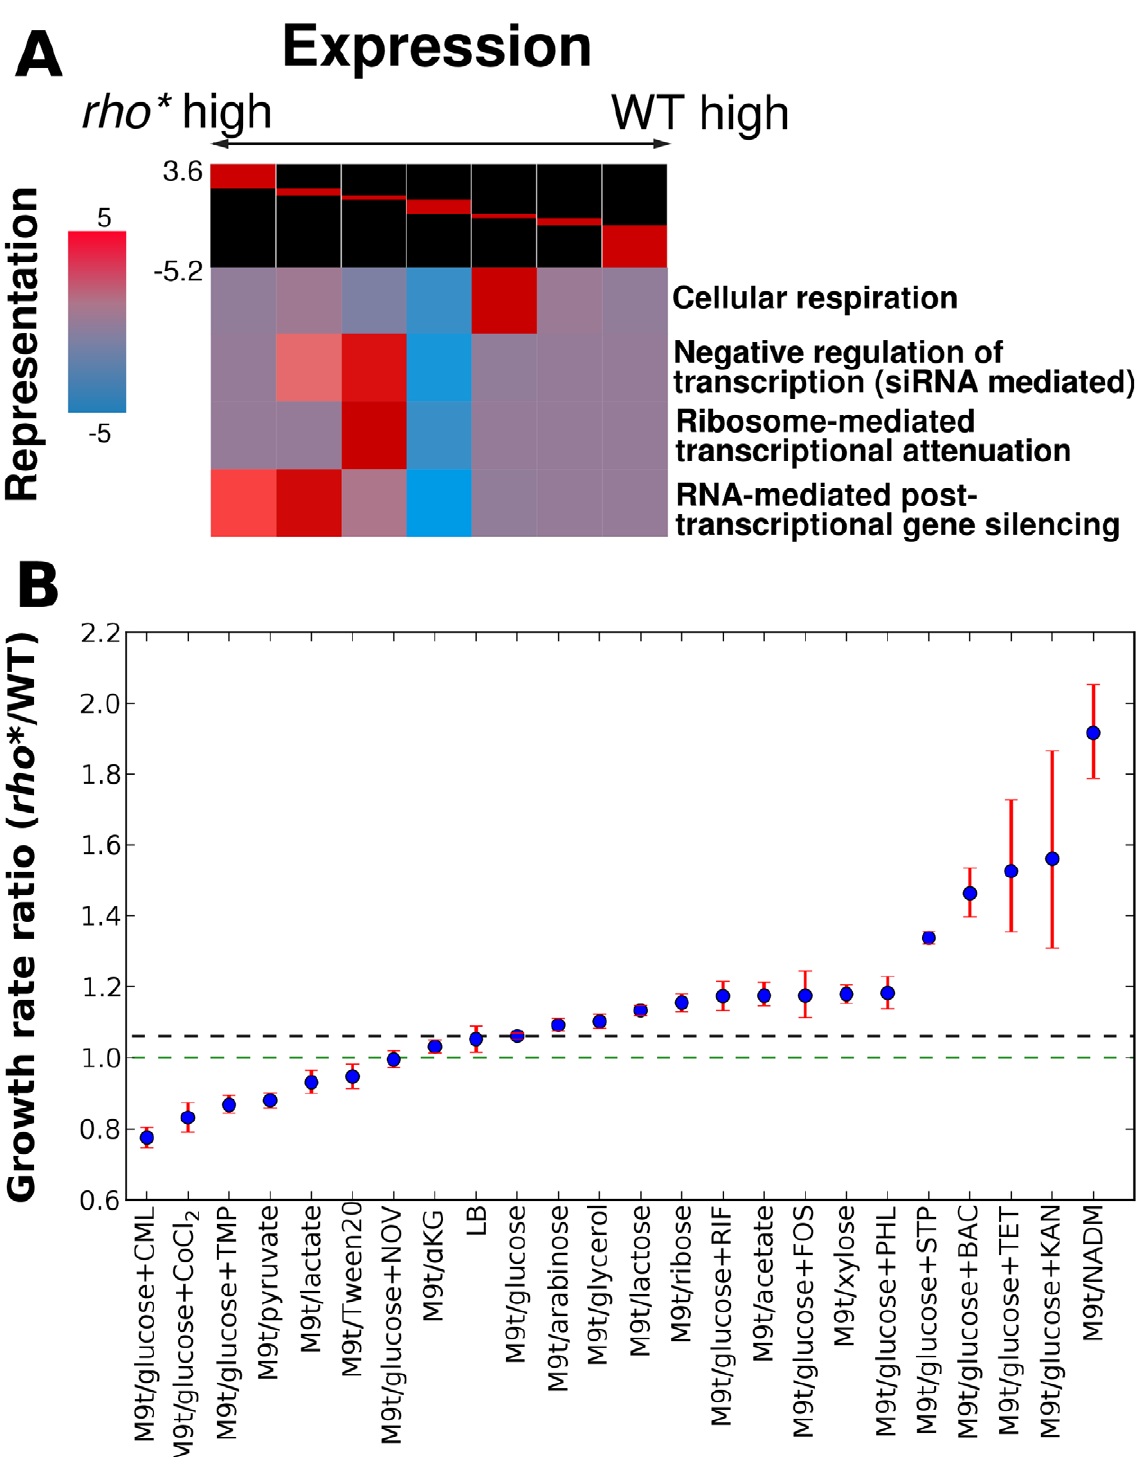
Figure 1. Comparison of transcriptional and phenotypic differences between WT and rho * cells. (A) Key pathways showing significant patterns of over- or under-expression in rho * cells, assessed using iPAGE [16]. The log ratios of rho * to WT RNA at each probe were discretized as shown at the head of each chart (breaks correspond to 3, 2, and 1.5-fold differences in either direction). For each pathway, coloring at each cluster corresponds to the degree of over- or under-representation of that cluster in the relative expression level of genes in that pathway (with magnitude equal to the negative log 10 p-value for significance of the representation; positive and negative scores represent over- and under-representation, respectively). (B) Ratios of rho * to WT growth rates under a variety of conditions showing significant fitness differences; dashed lines indicate the ratio under the reference condition (black) or for equal growth rates (green). Error bars show a 95% confidence interval based on 10,000 samples from the posterior parameter distribution (see Text S1, Section 1.3). Abbreviations are shown in Table S10. See Table 1 for concentrations of antibiotics used. Ratios of rho* to WT growth rates differ significantly from that in the reference condition M9t/glucose (non-overlapping 95% confidence intervals) for all cases except LB, which is included simply as a second useful reference.